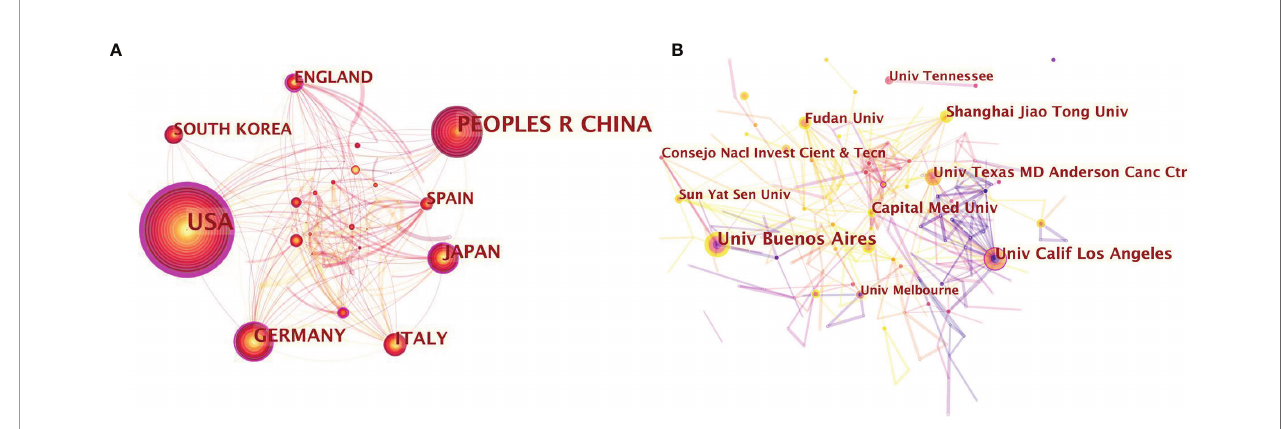
FIGURE 2 | (A) Citespace network map of 68 countries involved in neurotransmitters and tumor progression research; (B) Citespace network map of institutions involved in neurotransmitters and tumor progression research. Each circle represents an institution. Size of circle is positively correlated with the number of articles published by institutions, and links between two circles represents a collaboration between two institutions on the same article. Line thickness is positively correlated with frequency of collaborations. Top 10 institutions with the most publications are shown. (the University of Buenos Aires, the University of California Los